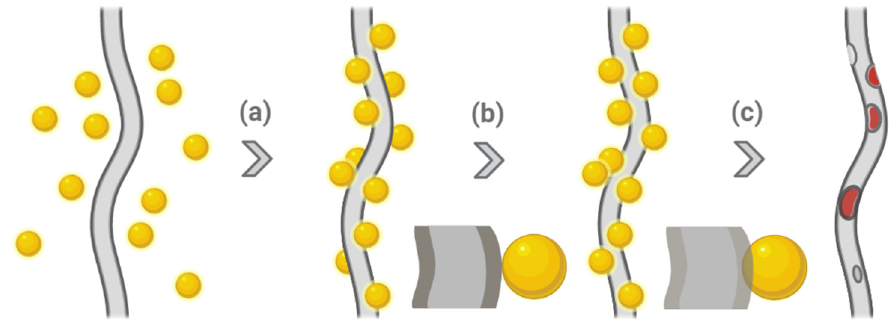
Figure 3. Sonication-triggered drug release. ( a ) Attachment of nanoparticles onto the surface of nanofibre, ( b ) embedding of nanoparticles by solvent vapor annealing, and ( c ) nanoparticles detached by ultrasonication-triggered drug release. Created with BioRender.com and adapted from [34].